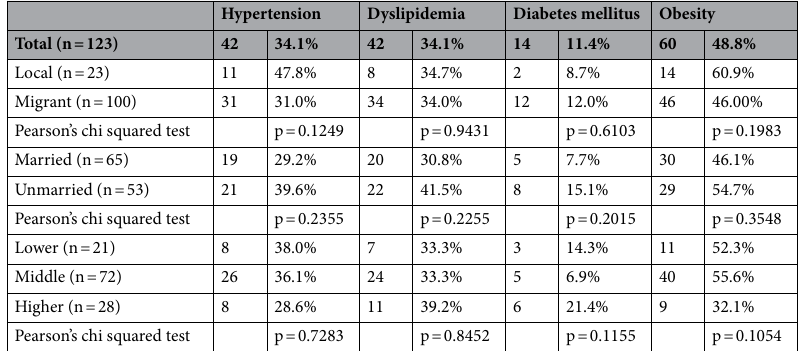
Table 2. Prevalence of non-communicable diseases among 123 healthy male decontamination